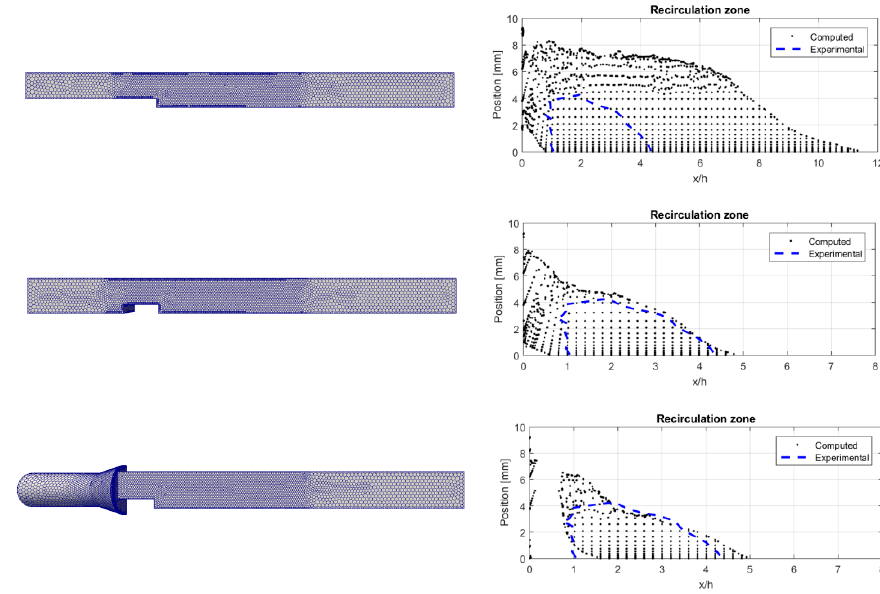
Figure 3. Backwards facing step mesh with increasing geometry detail (left) and the corresponding computed and experimental recirculation zones for pure water.